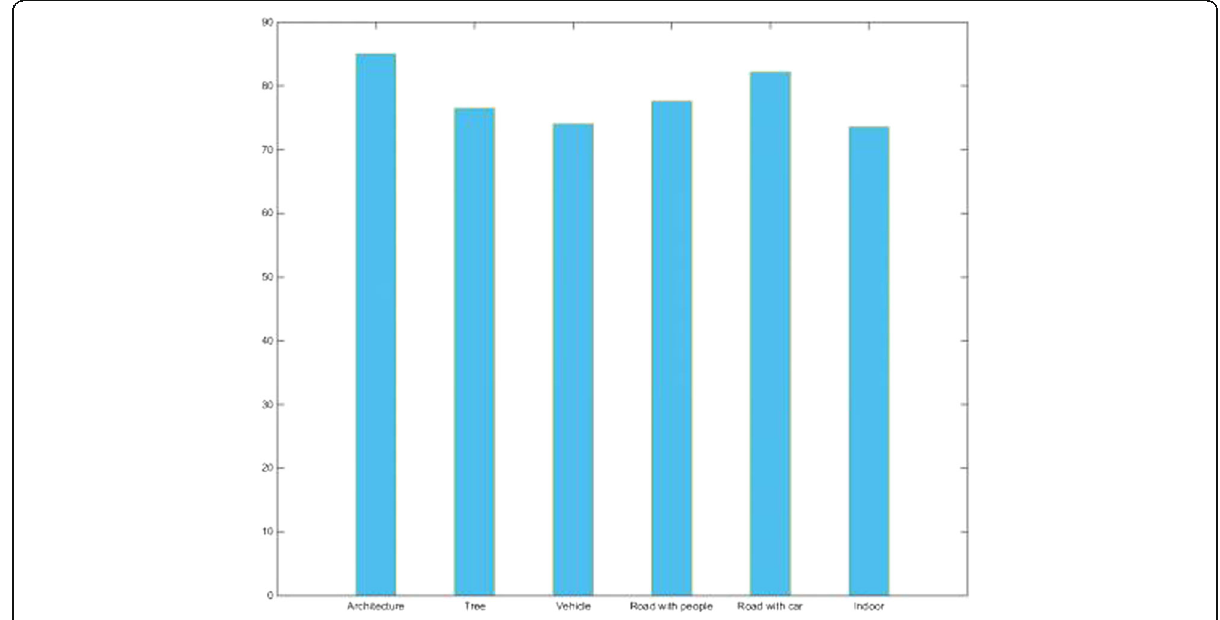
Fig. 4 AP values for different scenarios (the x coordinate is six different scenes and the y coordinate is the AP